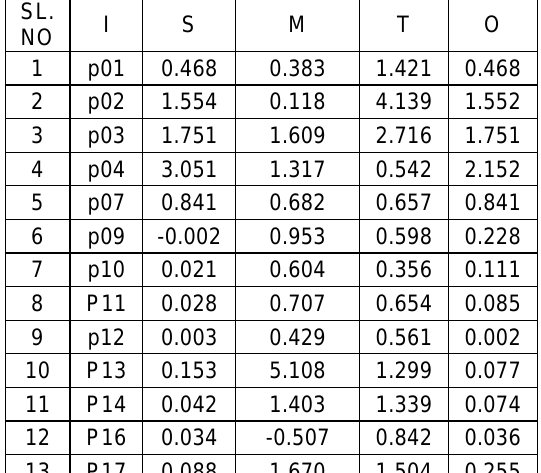
Figure 5. Performance of different techniques